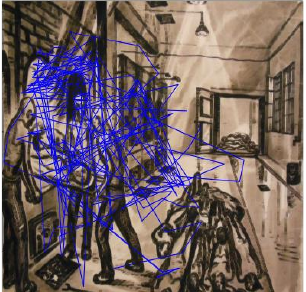
Figure 5. Gaze trajectories of all the participants who looked at this image of a crematorium.